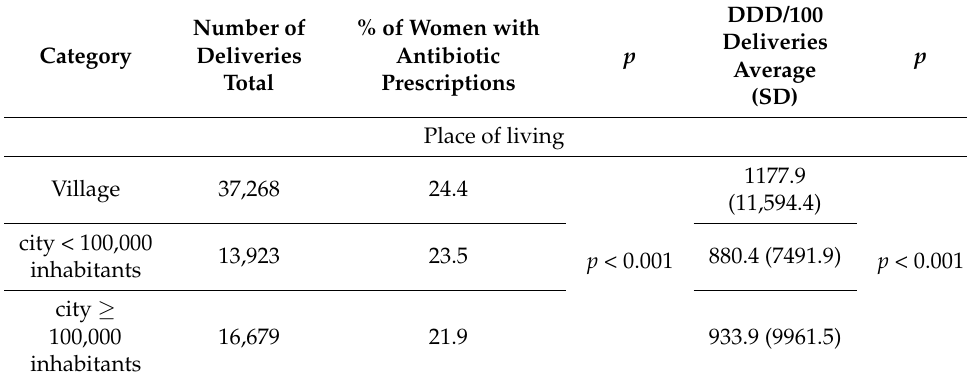
Table 2. Number of prescriptions and DDD for the whole period of pregnancy according to place of living, hospital type, women’s age, and type of